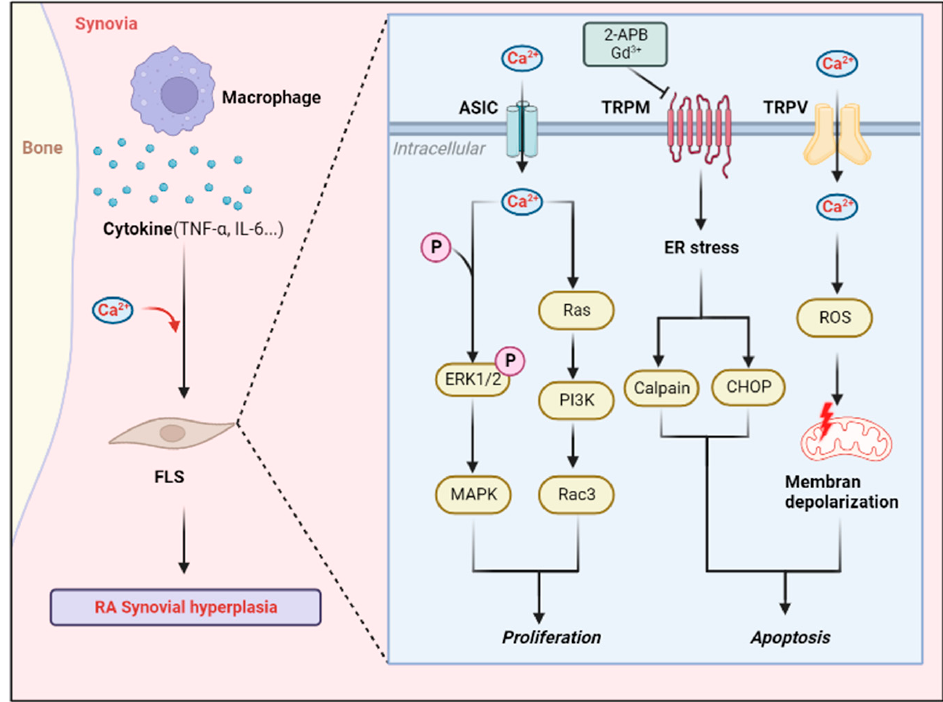
Figure 2. Role of calcium-permeable channel in synovitis. Macrophages can secrete a variety of cytokines to stimulate FLSs in the synovium, leading to a large influx of calcium ions in FLSs cells and triggering related cascade reactions, eventually leading to excessive apoptosis or proliferation of FLSs, and regulating synovial inflammation (created with Biorender.com).